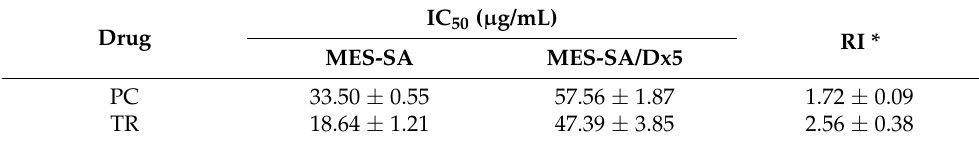
Figure 2. Inhibitory effects of Pituranthos chloranthus (PC) and Teucrium ramosissimum Desf. (TR) extracts on MES-SA and MES-SA/Dx5 cell proliferation. After treatment of MES-SA and MES-SA/Dx5 with increasing concentrations (0–100 µ g/mL) for 48 and 72 h of PC ( A ) and TR ( B ), the percentage of cell viability was determined using the (3-(4,5-dimethylthiazol-2-yl)-2,5-diphenyltetrazolium bromide (MTT) assay. The results are expressed as a mean percentage of control growth ± Standard Deviation (SD) of three independent experiments. Table 2. The resistance index (RI) for PC and TR after 72 h of